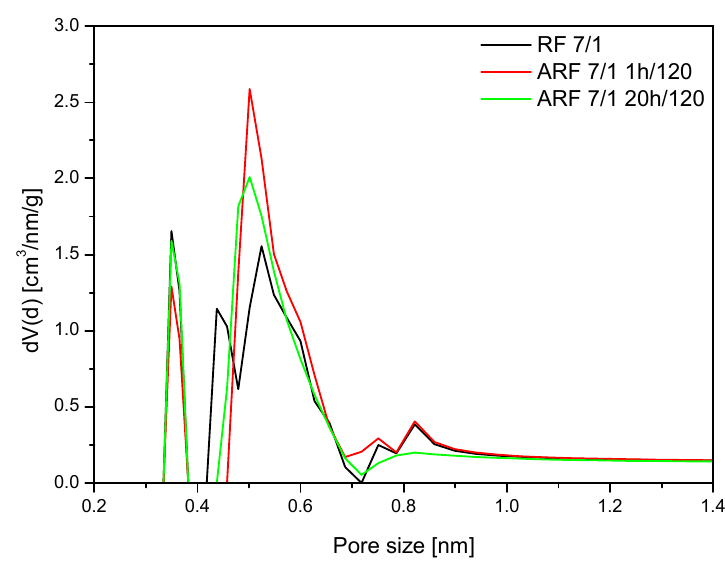
Figure 8. Pore size distributions of the samples modified with potassium